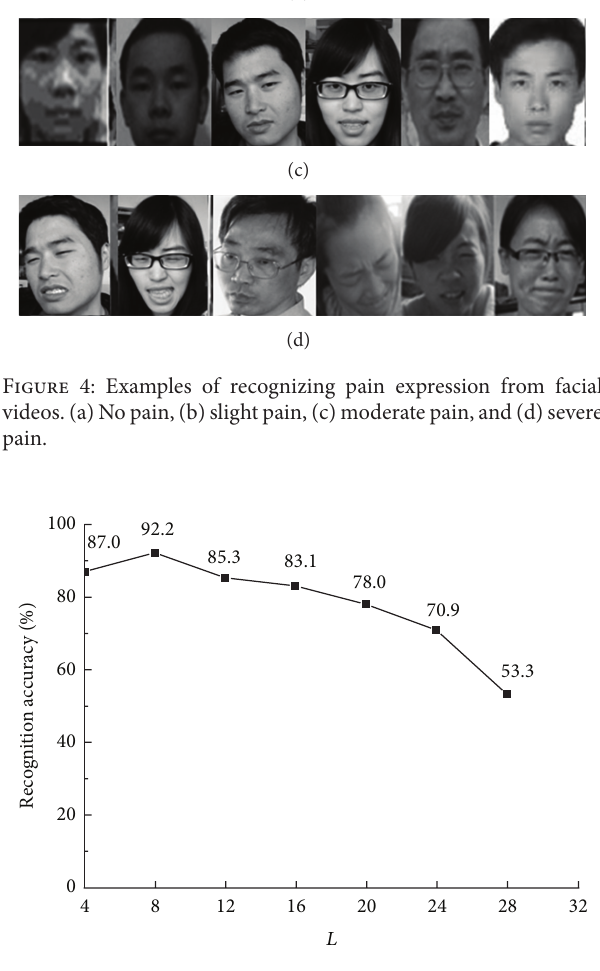
Figure 5: Recognition accuracy curve with different block sizes.